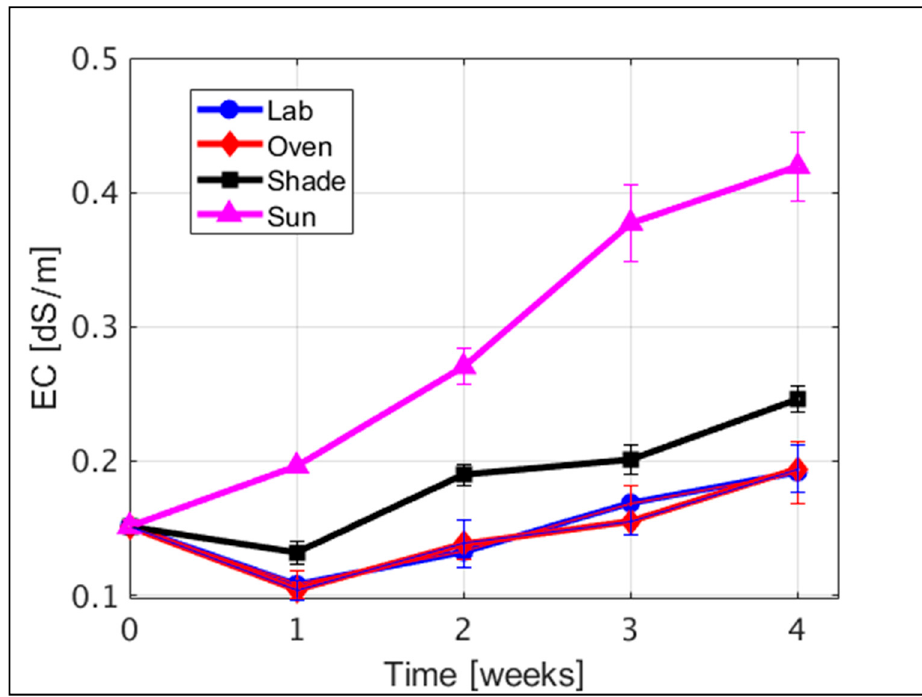
Figure 6. Temporal changes in the EC readings of the leachate water from the ‘Lab’, ‘Oven’, ‘Shade’, and ‘Sun’ bitumen sheets.